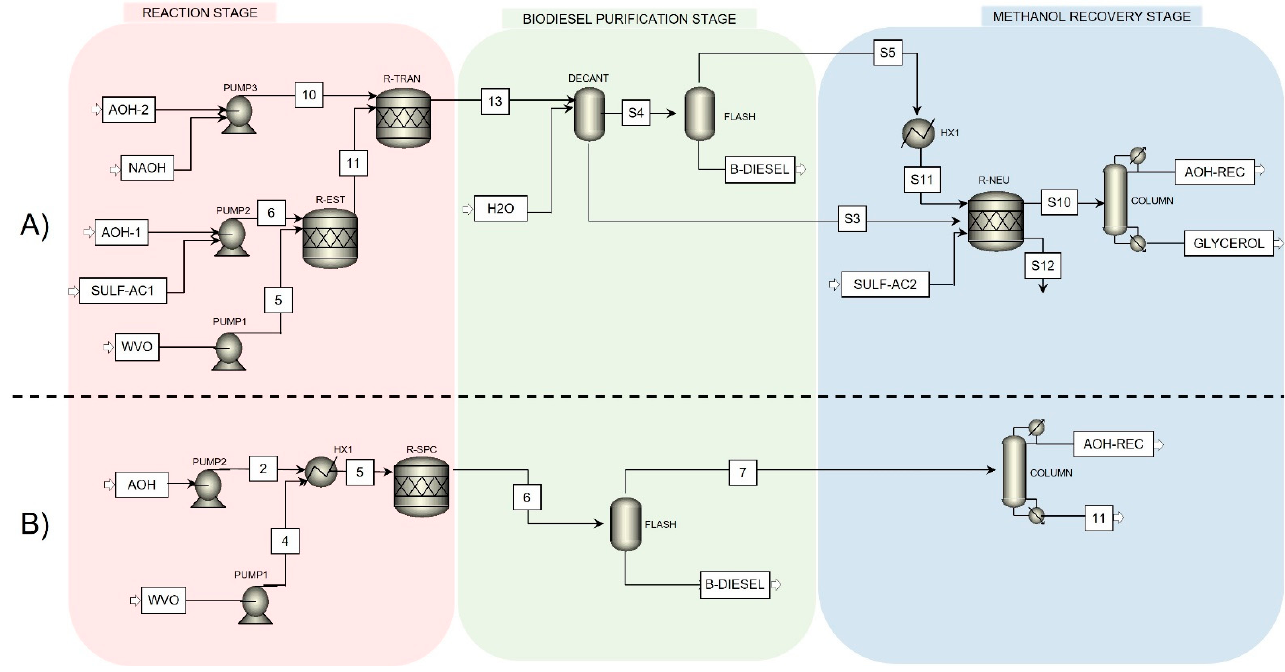
Figure 1. ASPEN PLUS ® diagram of biodiesel production process by alkaline catalysis ( A ) and supercritical conditions ( B ).